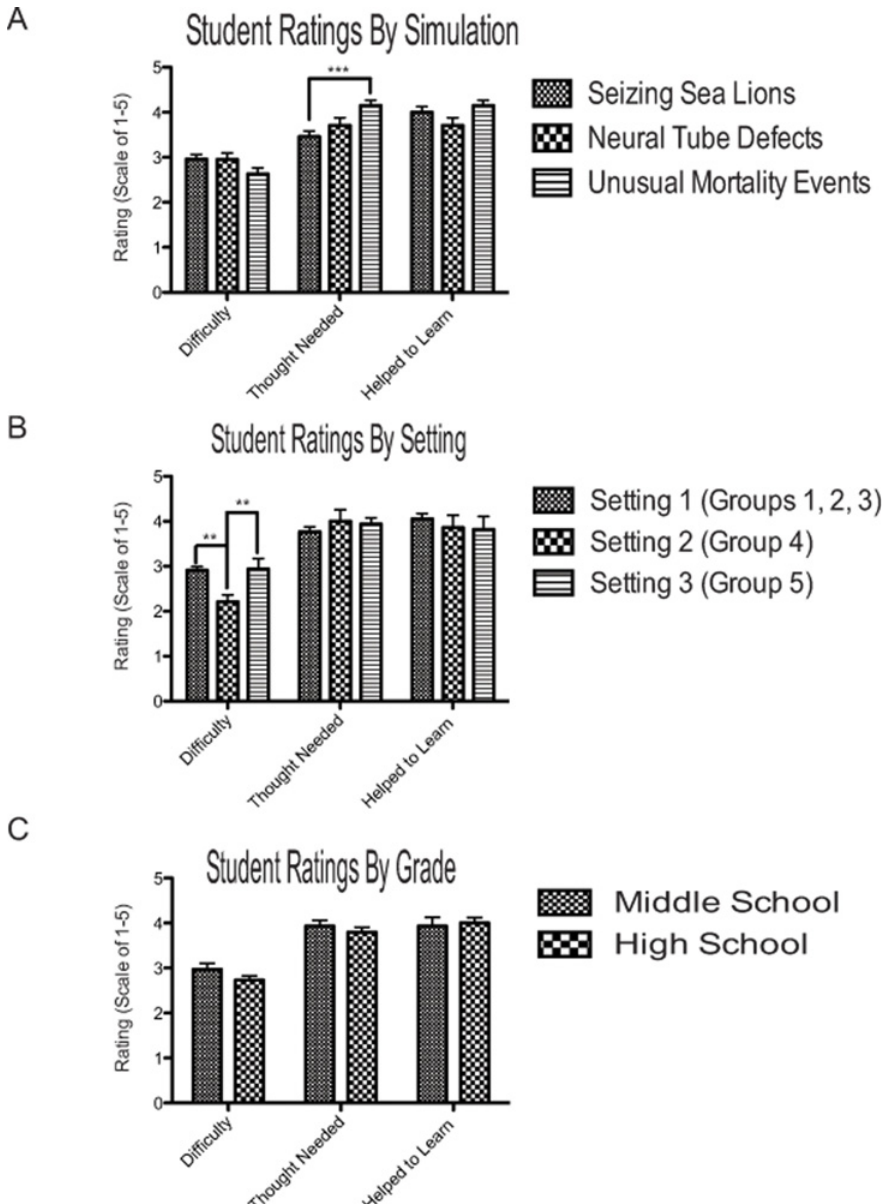
Fig 2. Student ratings of difficulty, thought needed, and learning efficacy are impacted by simulation and setting, but not grade. (A) No statistically significant differences were observed between simulations in regards to difficulty (One-way ANOVA, p > 0.05). However, students reported that the Unusual Mortality Events simulation required much greater thought to complete that the Seizing Sea Lions simulation (One-way ANOVA, p = 0.001). (B) The setting (Table 1) where the SCI simulations were used did not have an effect on the amount of thought needed to complete the simulation or how much the simulation helped the student to learn (One-way ANOVA, p > 0.05). However, the students in Setting 2 had an easier time completing the simulation than students in Setting 1 or 3 (One-way ANOVA, p = 0.004 and p = 0.014 respectively). (C) Analysis of middle school and high school students across all three settings indicated no statistically significant differences in difficulty, thought required to complete the simulation, or the amount the simulation helped them to learn (Independent samples t-test, p > 0.05). Graphs represent the average score on a 5- point Likert scale where 5 represents a high and 1 a low rating and error bars represent SEM.